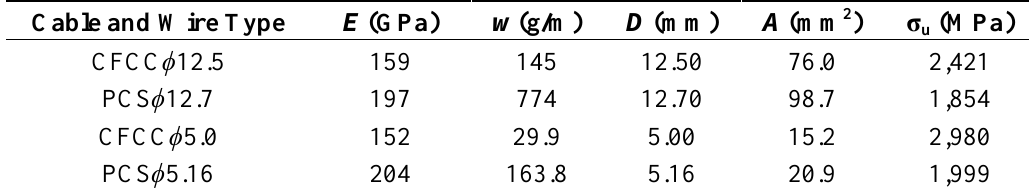
Table 2. Material properties of cables and